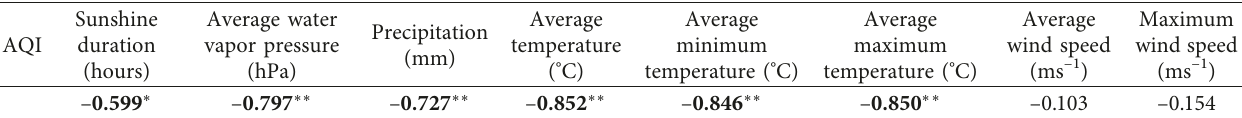
Table 3: Correlation coefficient of monthly AQI with corresponding monthly values of parameters in Jiangsu Province in the period 2013-2017.